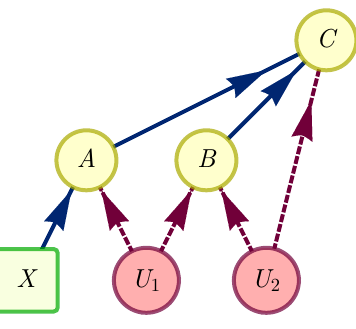
Figure 10: The example structure 𝒢 1 . (Not a correlation